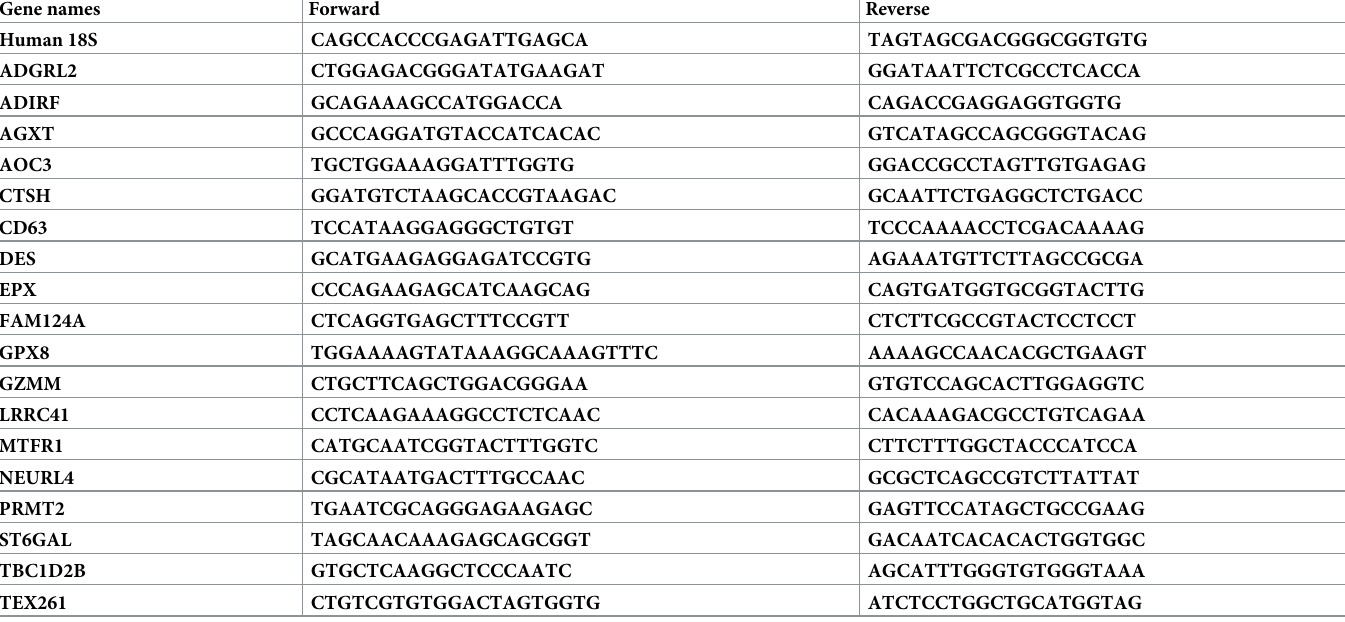
Table 1. Primer sequences against human cDNA sequences used for qRT-PCR. Sequences are listed in the 5’ to 3’